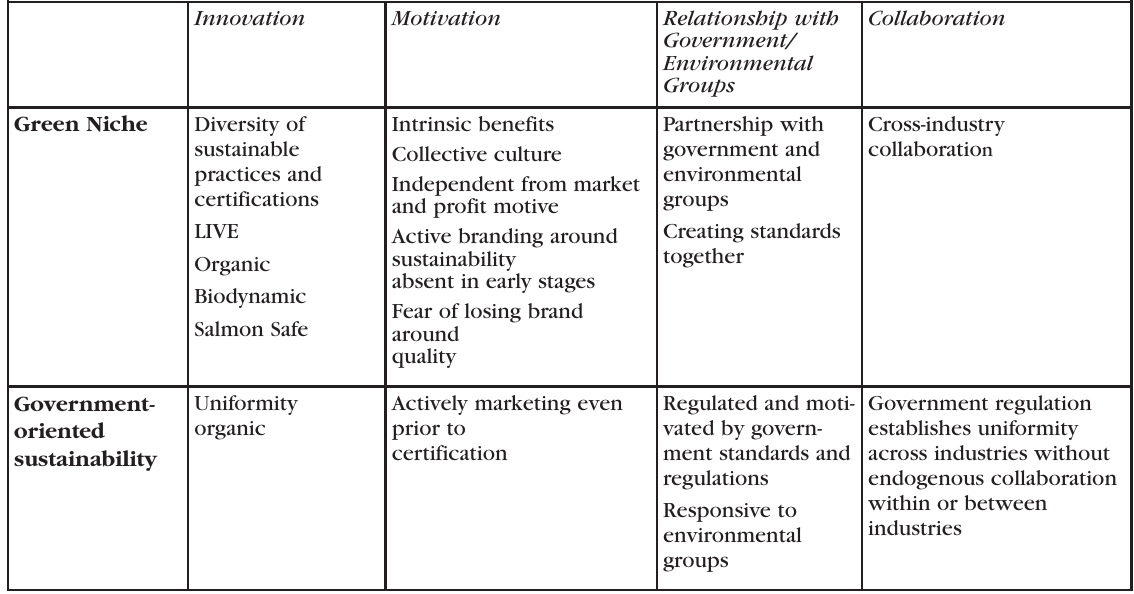
Table 3. Characteristics of Niche-driven and Government-oriented Sustainability